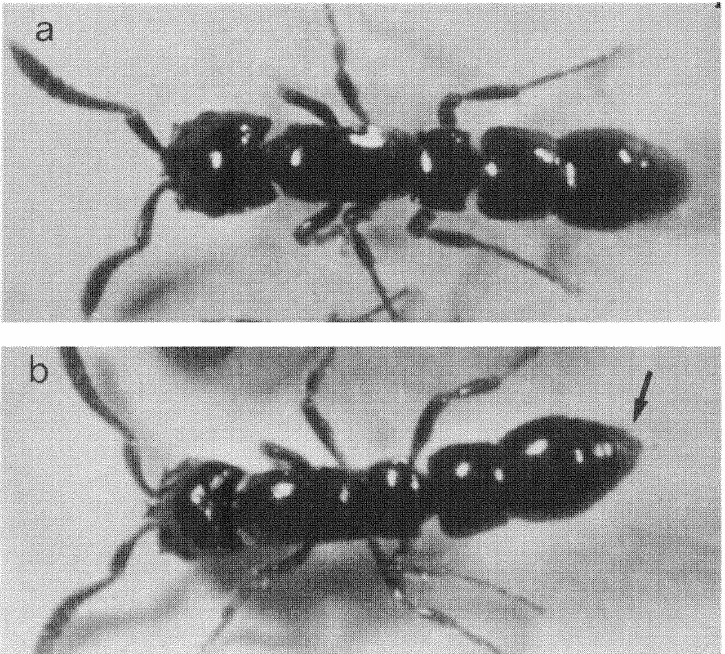
Figure I. Recruiting Cerapachys worker. (a) Worker walking with its abdomi- nal tip close to the ground. (b) Worker raising the gaster upwards; arrow indicates the position of the opening of the pygidial